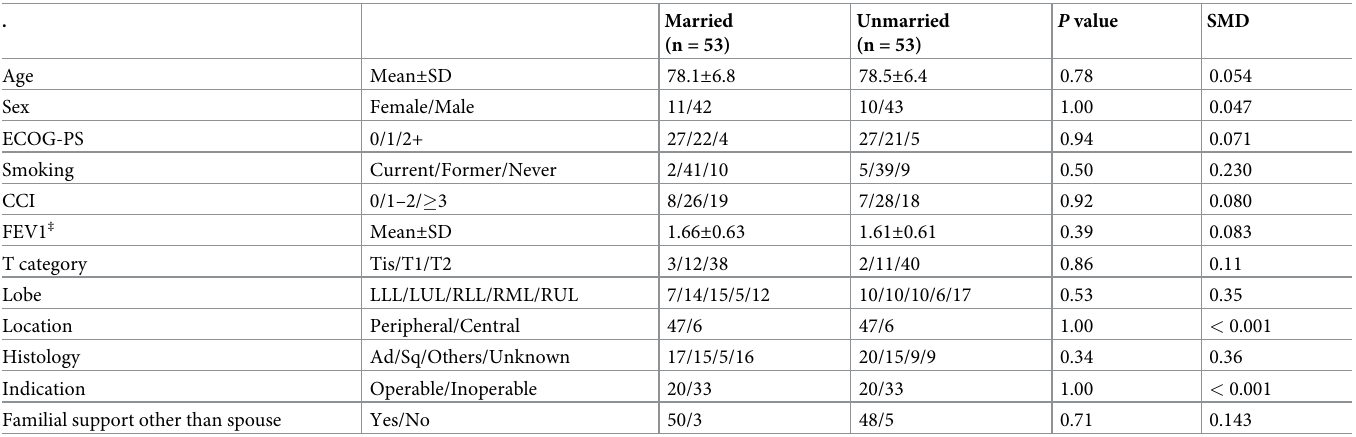
Table 3. Patient characteristics of the matched cohort.